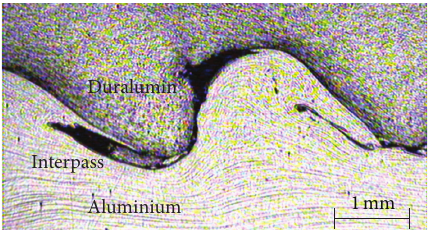
Figure 11: The macrostructure of the aluminium-duralumin joint area, showing the wavy joint with interpass and significantly deformed joint boundary layers of both welded materials.